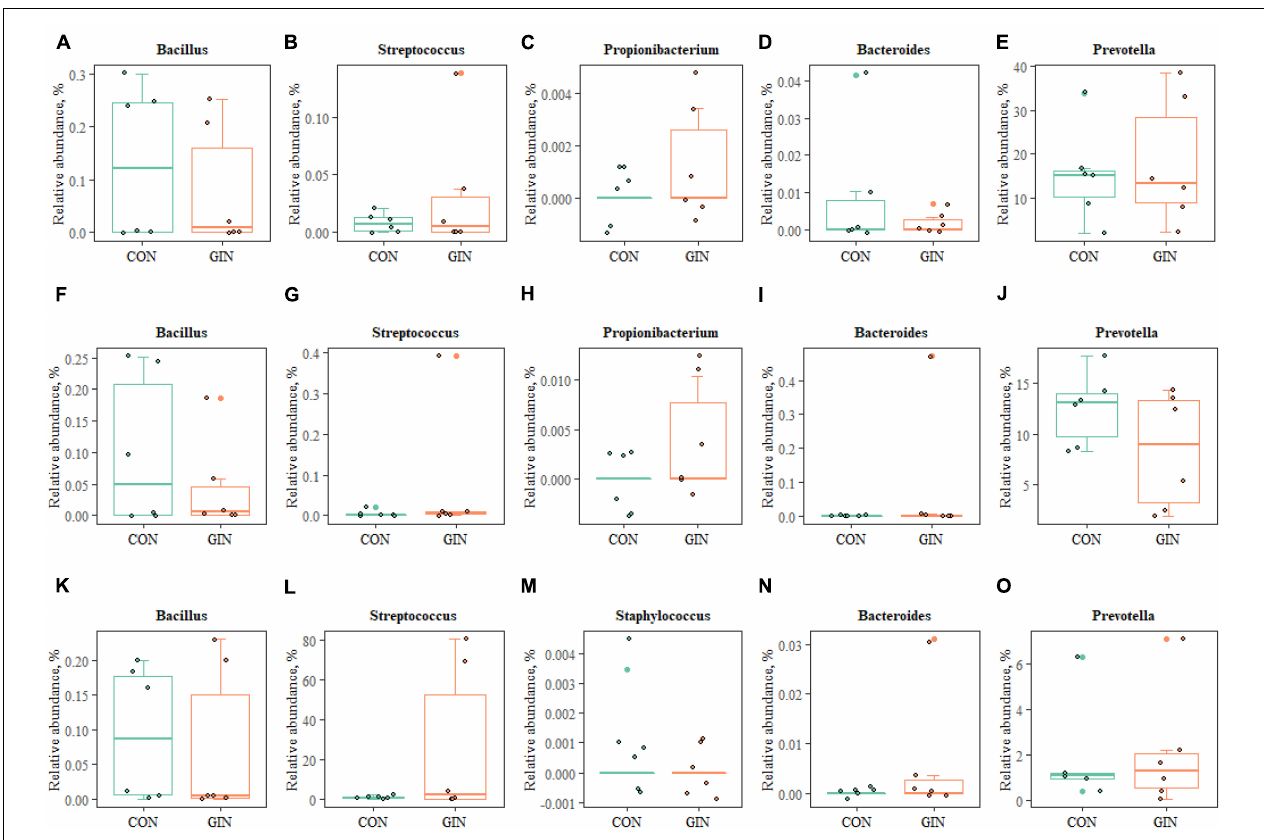
FIGURE 7 | The proteolytic bacteria of rumen (A–E) , abomasum (F–J) and duodenum (K–O) at genus